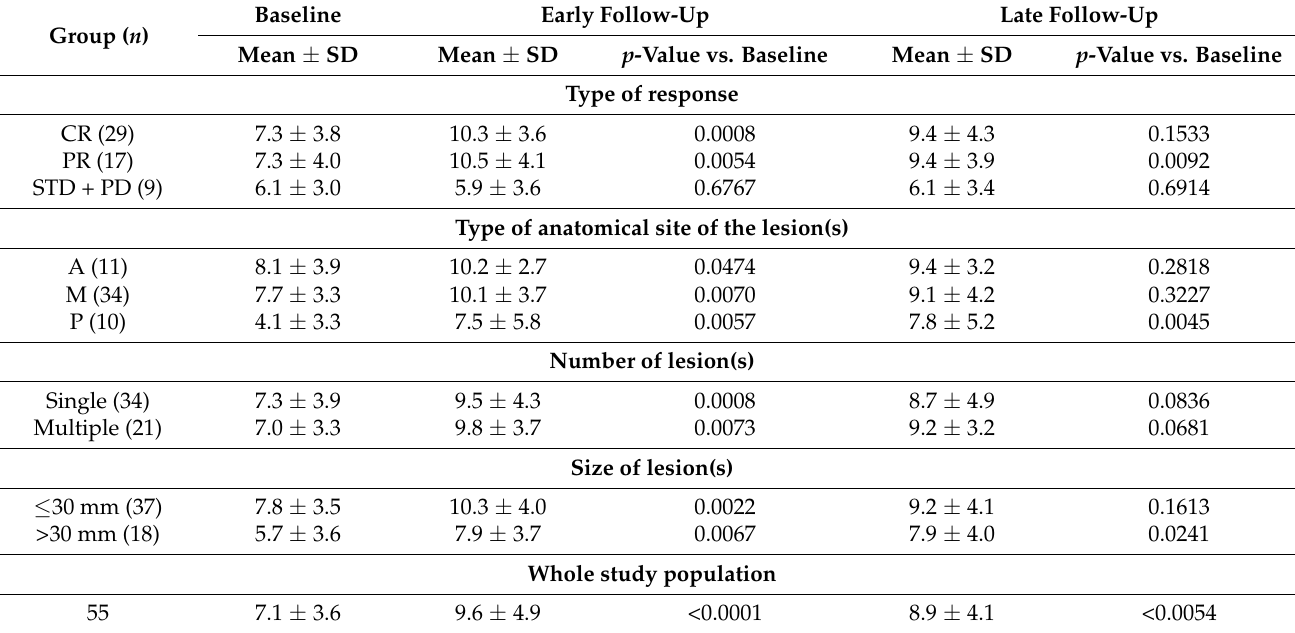
Table 2. Functional Assessment of Cancer Therapy—Vulva cancer. Values refer to the median of the following four items: bleeding, burning, urination and sitting.